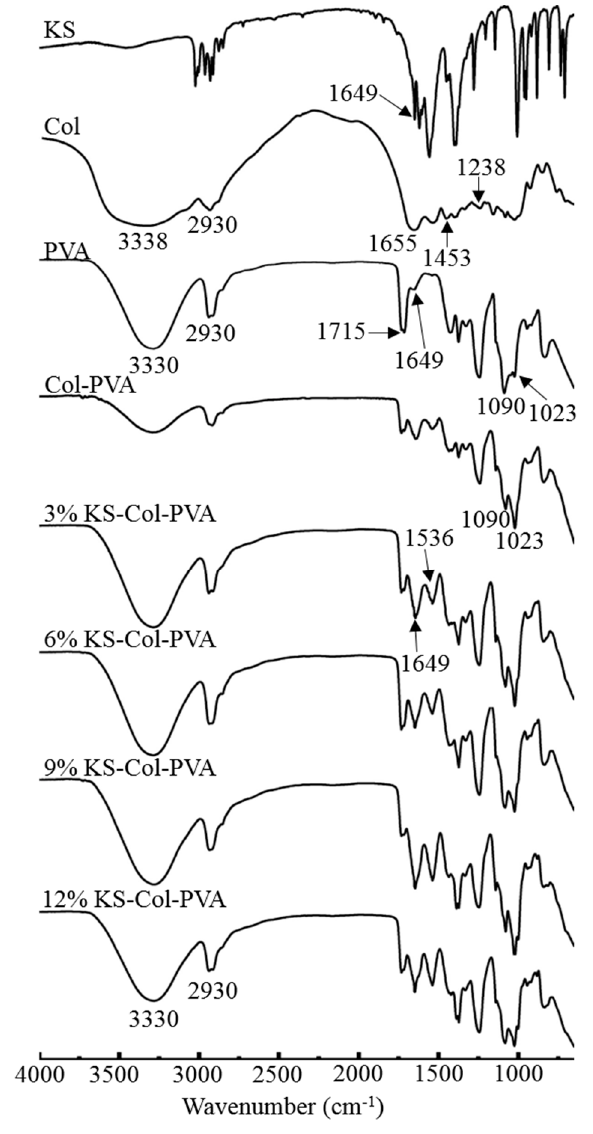
ff erent composite